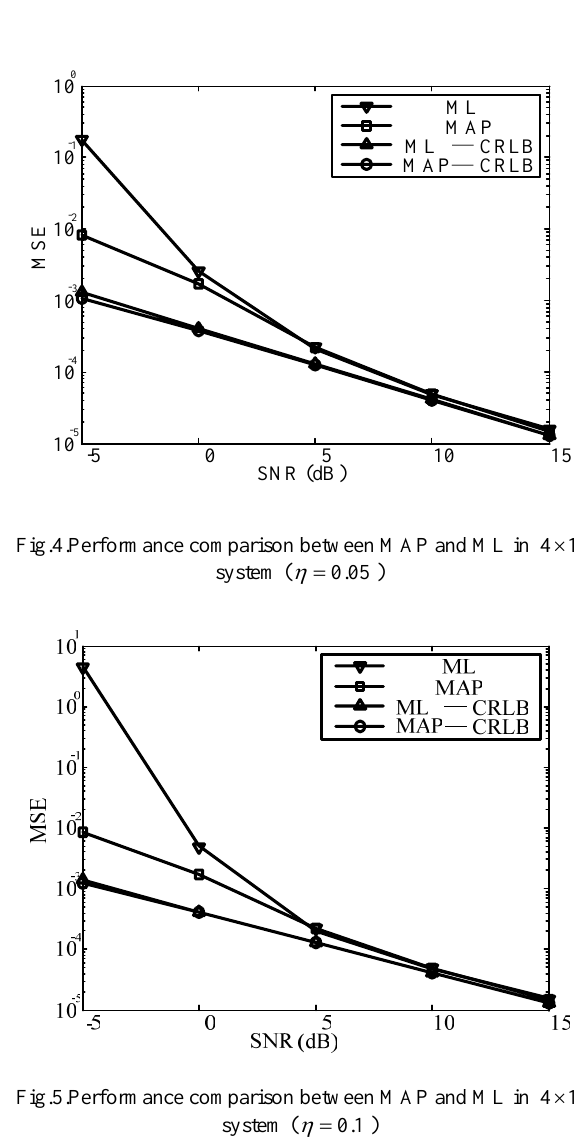
Fig.5.Performance comparison between MAP and ML in 4 1 × system ( 0.1 η= )